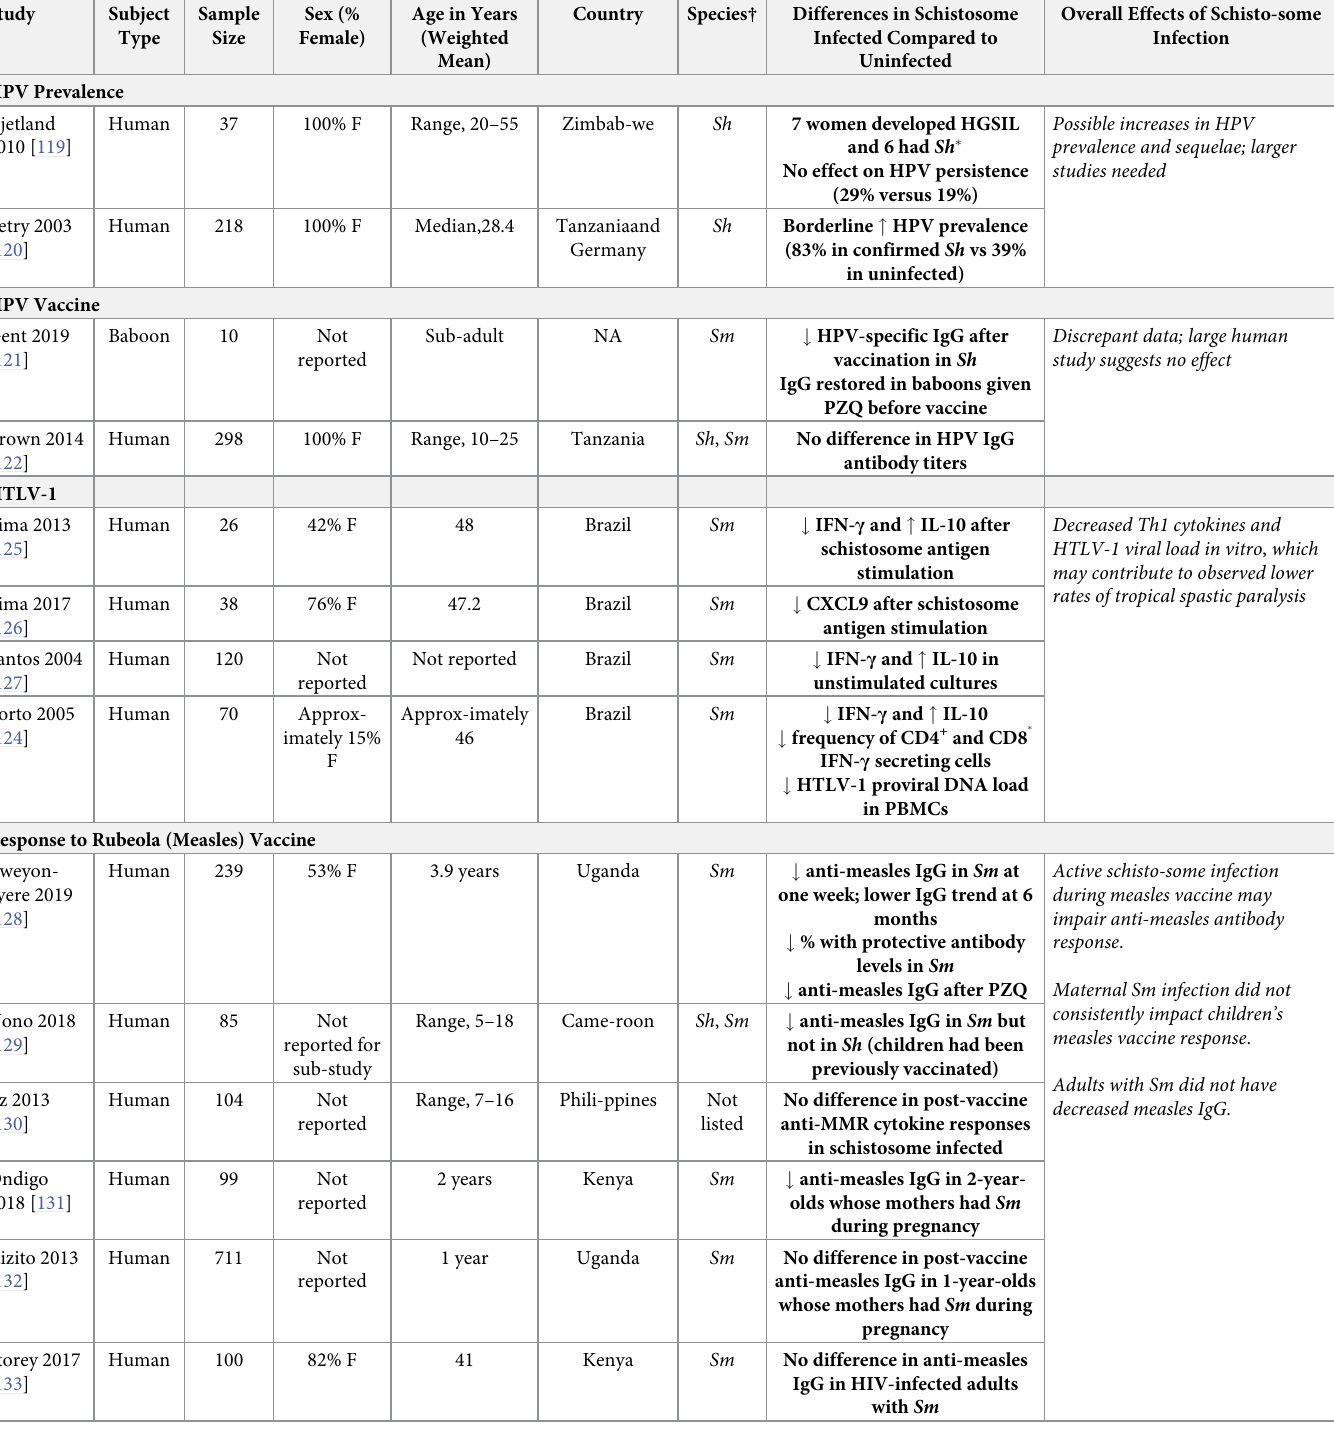
Table 9. Schistosomes and Interactions with HPV, HTLV-1, and